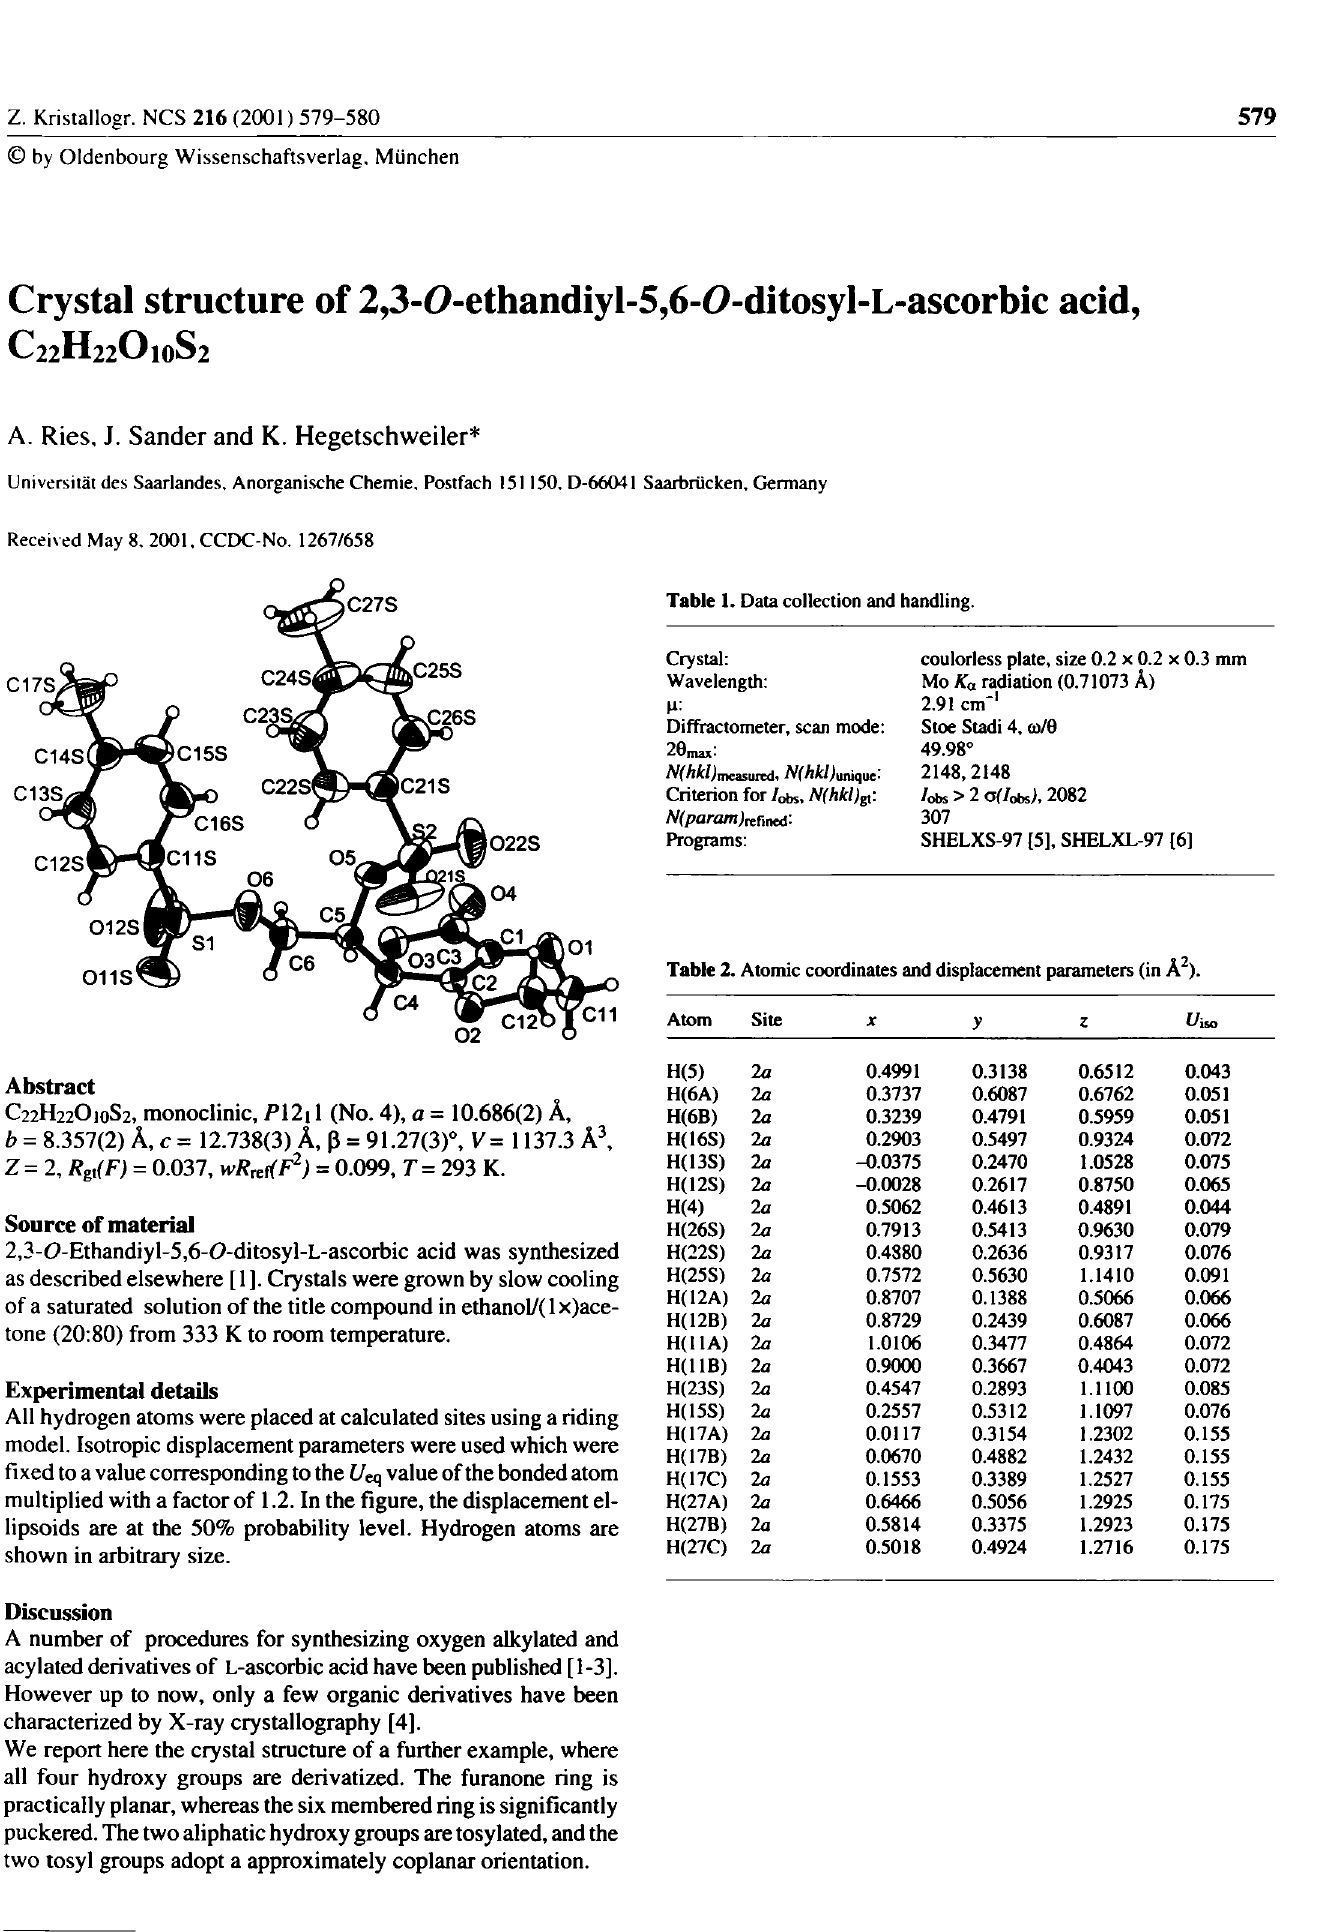
Table 2. Atomic coordinates and displacement parameters (in A 2